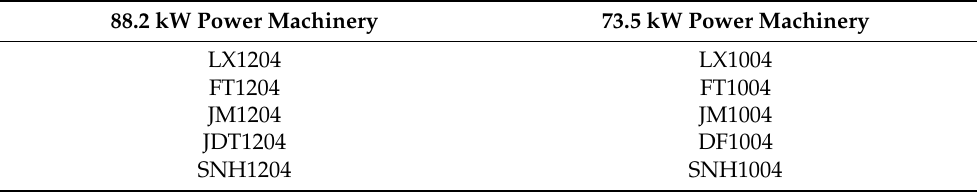
Table 2. Power machinery type.